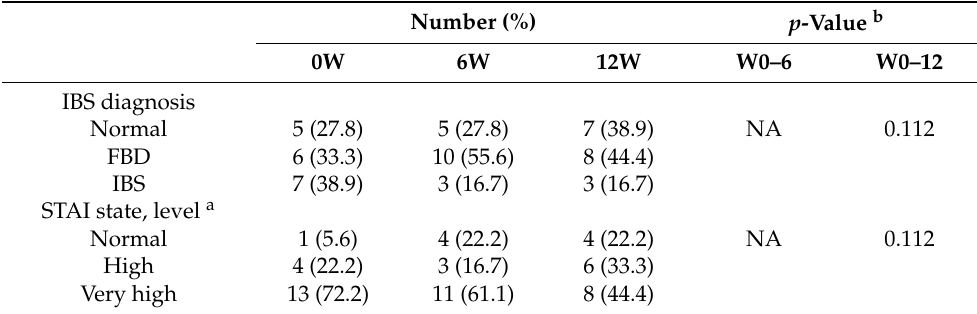
Table 2. Changes in IBS diagnosis and state anxiety levels rated by the